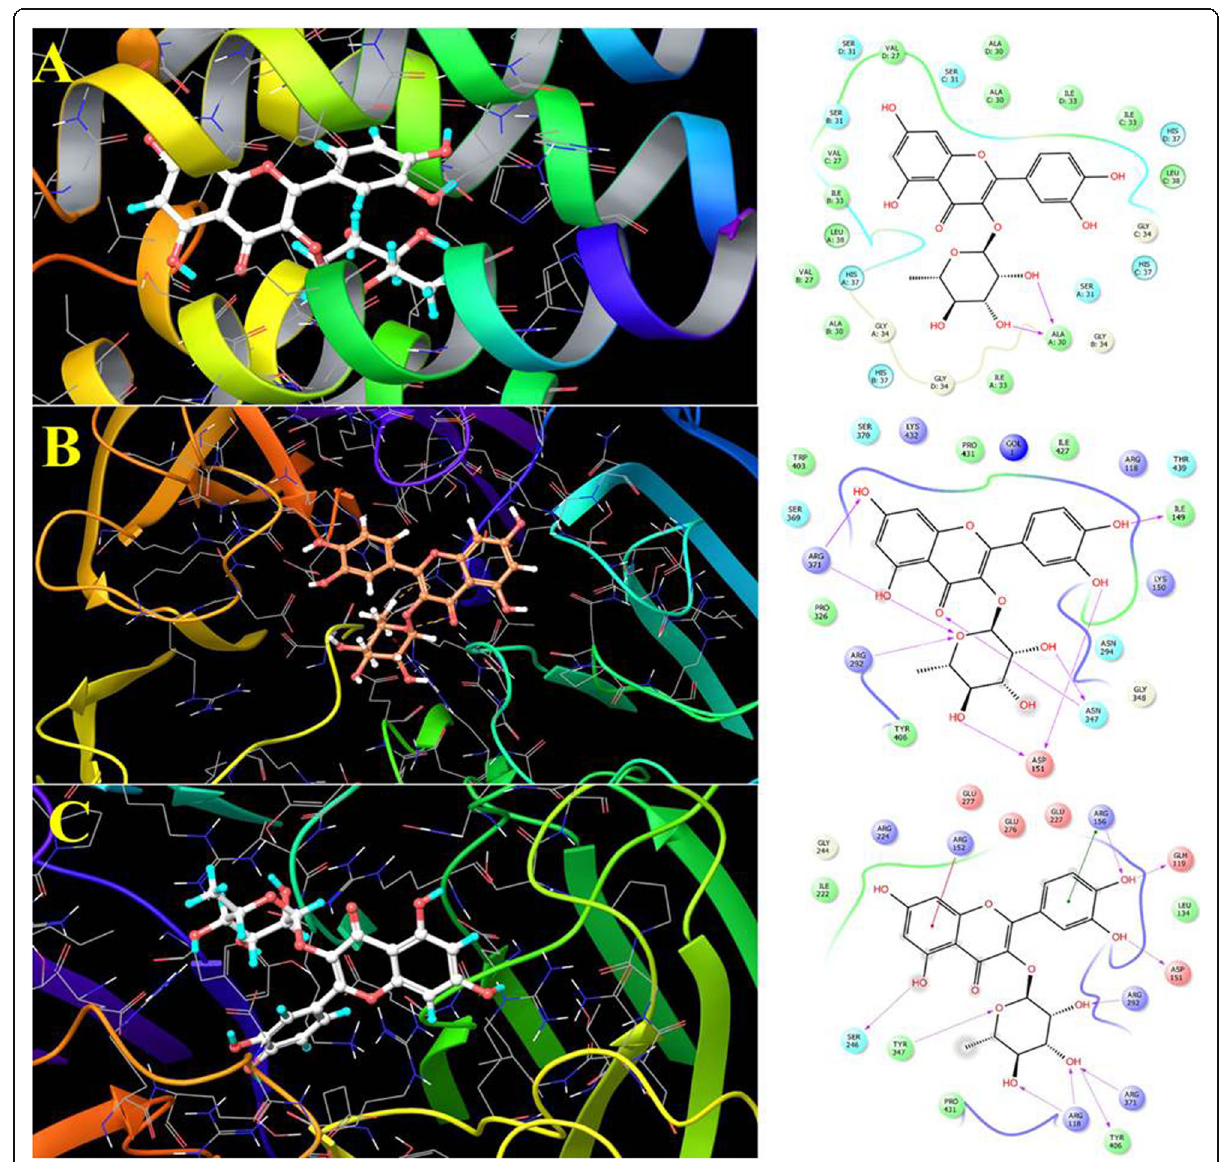
Fig. 5 The 2D interaction and 3D docking model of Q3R with a ) M2 transmembrane (2KQT) and b ) Neuraminidase 2009 pandemic H1N1 (3TI6) receptors from influenza virus and c ) human Ras homolog family member A (RhoA). The docking was performed using Glide application using Schrödinger drug discovery